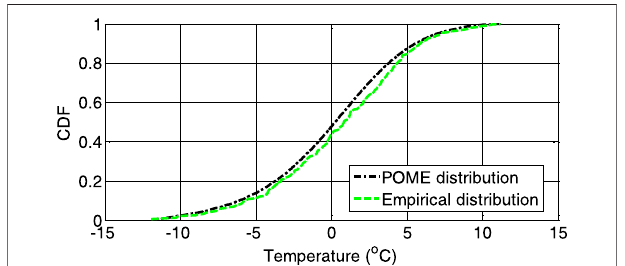
FIGURE 6 | CDF of the ambient temperature.